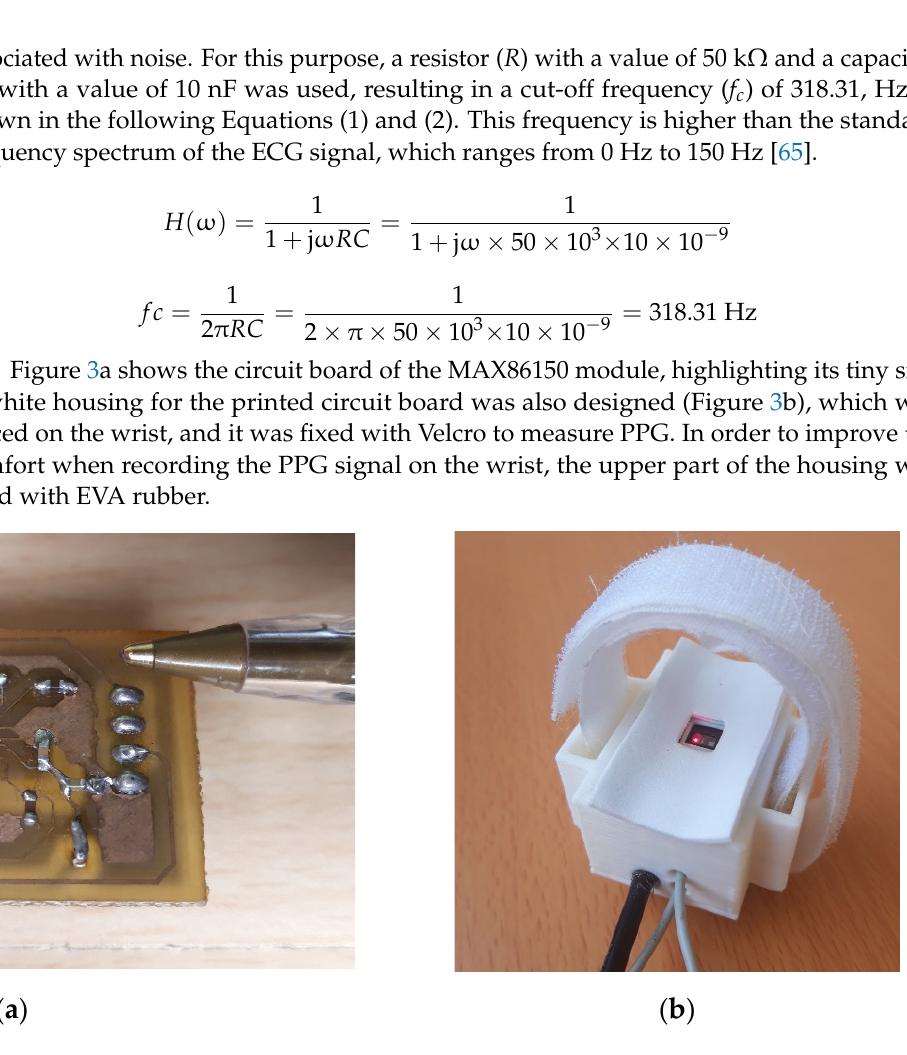
Figure 3. ( a ) MAX86150 sensor printed circuit board; ( b ) White housing for the MAX86150 module printed circuit board. printed circuit